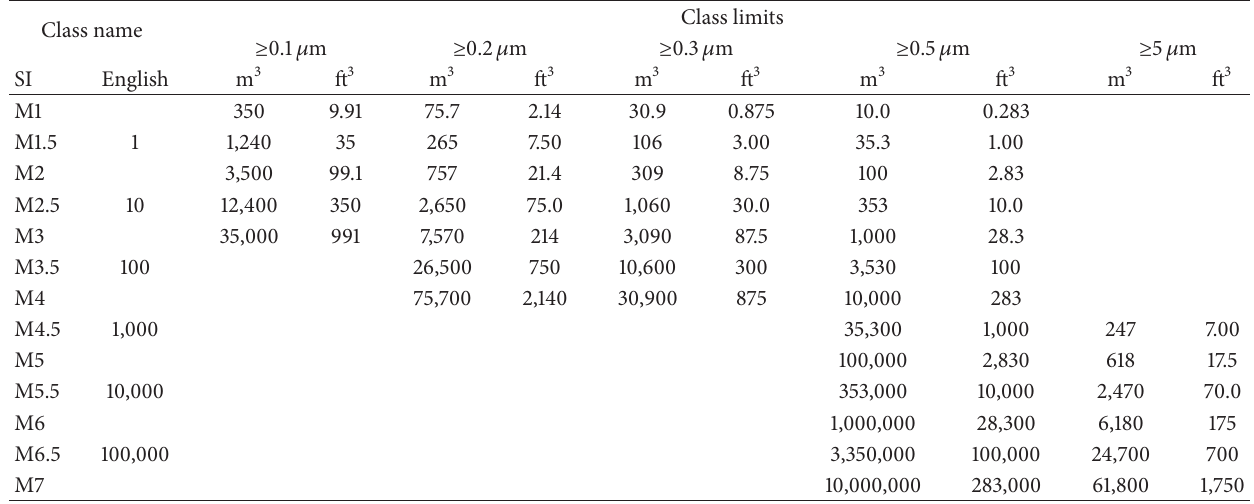
Table 1: Federal Standard 209E. Class limits are given for each class name.